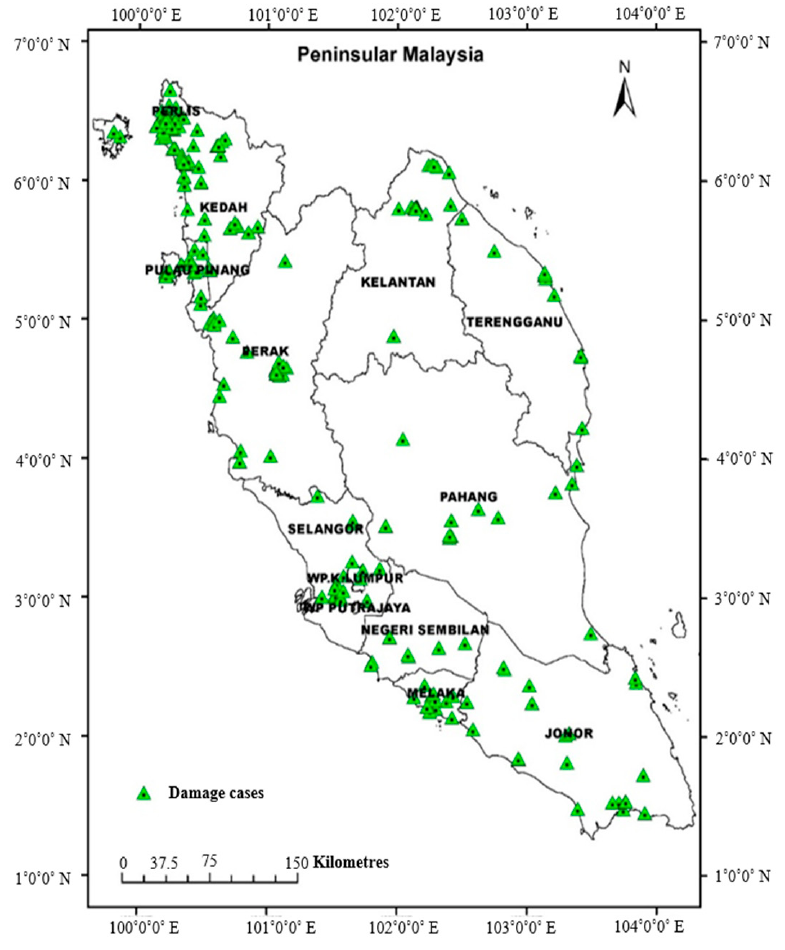
Figure 2. Selected area of study.